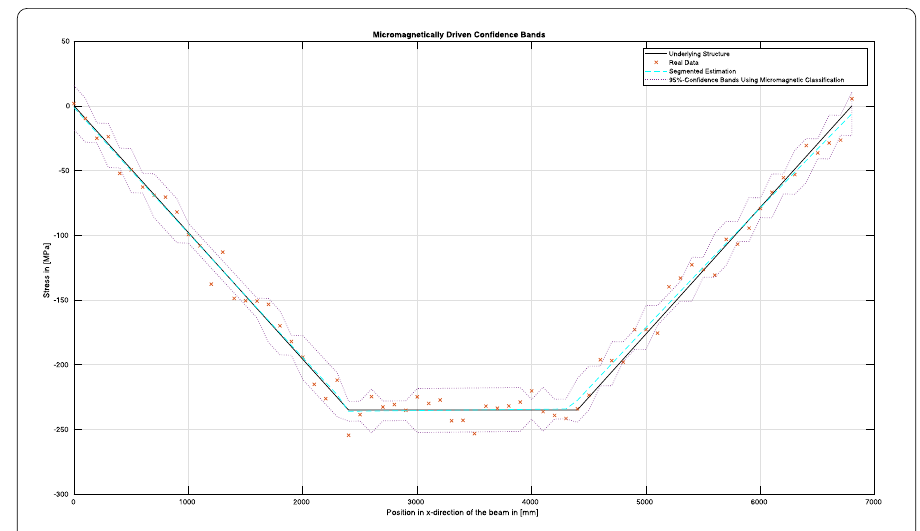
Figure 15 The analytic (blue) curve, the under idealised conditions recorded data (orange) the estimated curve (cyan) with smaller confidence bands (purple) compared to the classical